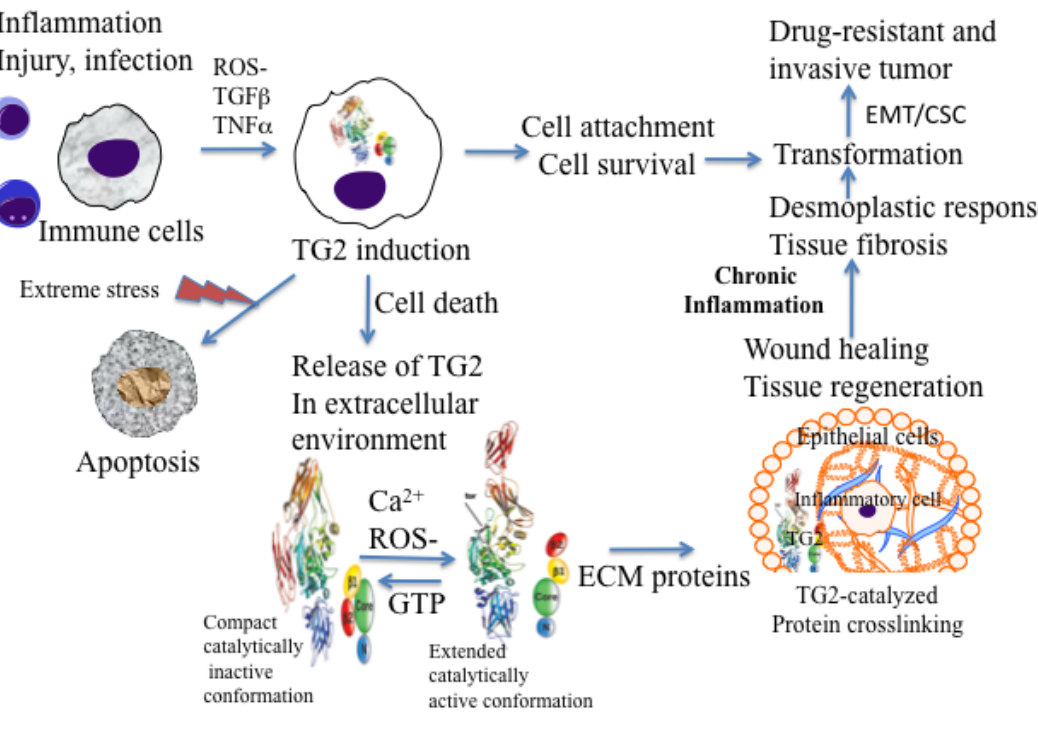
Figure 1. Possible role of inflammation-induced TG2 expression in initiation and progression of